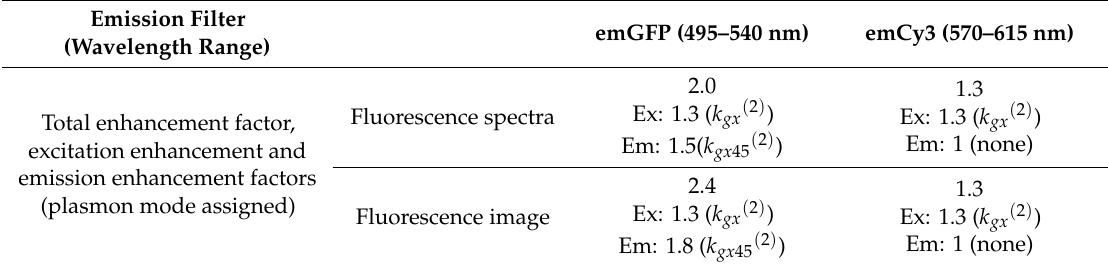
Table 6. Enhancement e ff ect of YG with exCFP for the 2D chip in the epi-optical system.